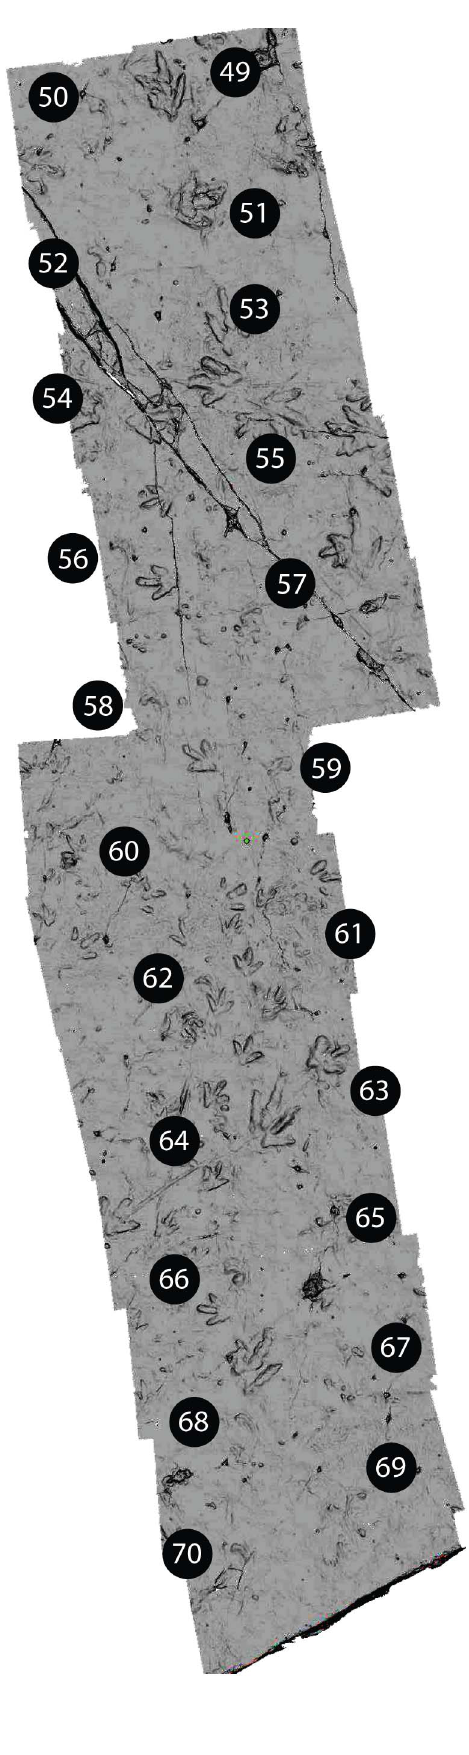
Figure 3. Moyeni tracksite, overview of scanned surface. This map, which includes Episcopopus ventrosus manus-pes pairs 49–70 (Ellenberger’s [3] numbering), was constructed from a series of 50 6 50 cm scans. For higher resolution images, see Figures